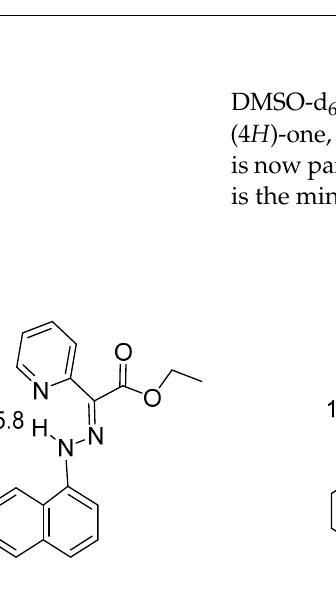
Figure 10. Comparison of rotamers. The numbers are NH chemical shifts in ppm. The chemical shifts are from [36]. The NH chemical shifts for the corresponding benzene derivative (benzene instead of naphthalene) are 14.6 ppm instead of 15.8 ppm. [34] If the ring is a 8 ‐ benzoquinoline the chemical shift is 15.36 ppm [37].